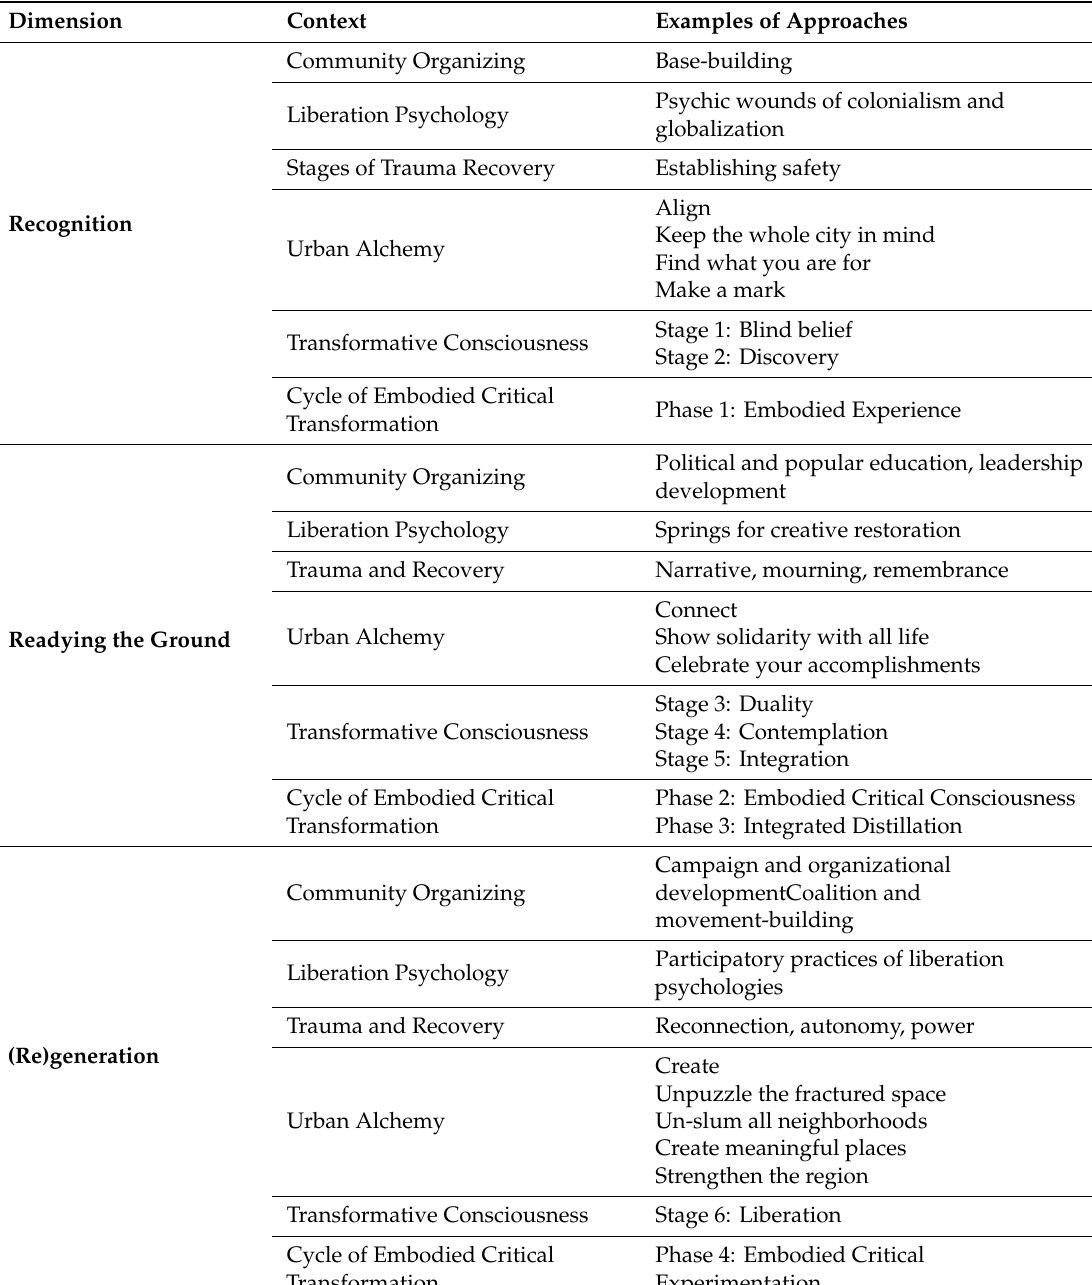
Table 4. Examples of concepts, practices, and stages from various models for each